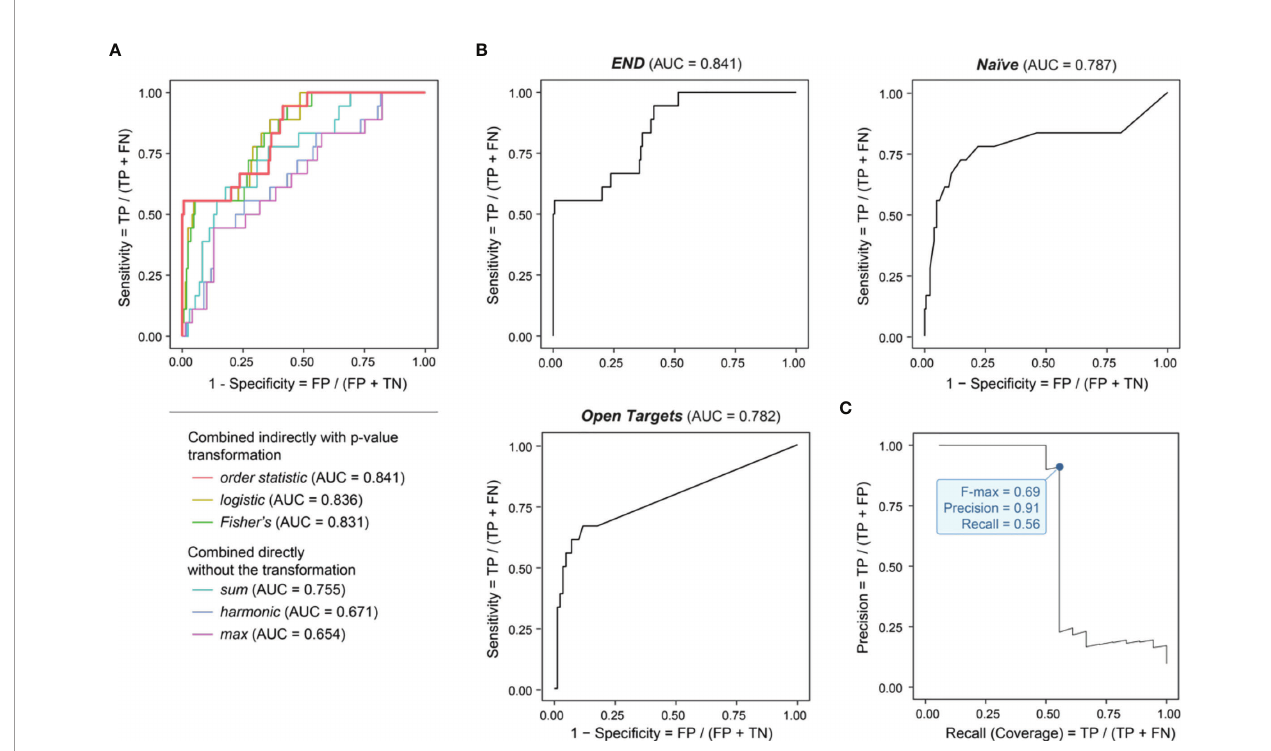
FIGURE 2 | Genomic prioritization in endometriosis. (A) Comparisons of strategies combining predictors. The combination strategy based on order statistic achieves the optimal performance, measured by the area under the ROC curve (AUC) separating clinical proof-of-concept targets from simulated negative controls. FN, false negatives; FP, false positives; TN, true negatives; TP, true positives. (B) Benchmarking prioritization approaches as described in Figure 1 , in terms of AUC. (C) Precision-Recall curve for END , with the F-max metric indicated (corresponding to 91% precision and 56%